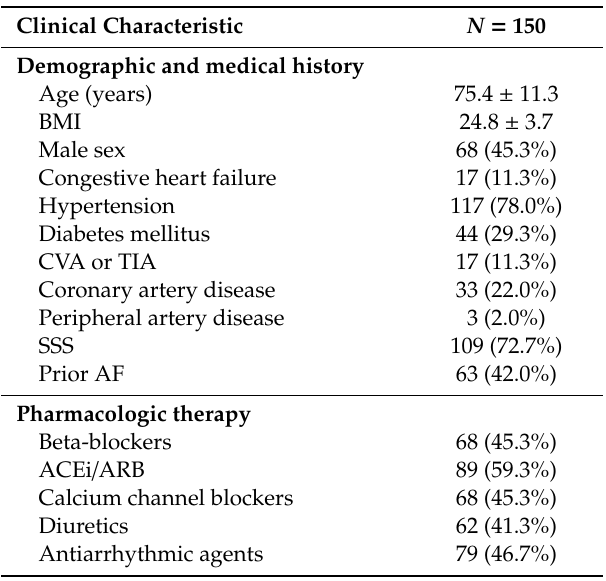
Table 1. Baseline characteristics of study participants.